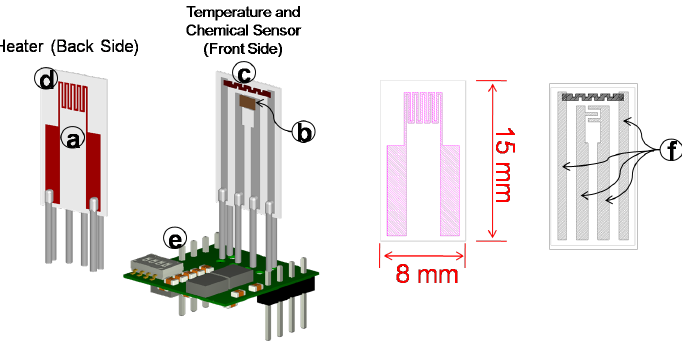
Figure 5. Sensor structure: ( a ) alumina substrate; ( b ) sensing film; ( c ) temperature sensor (Pt-Resistance Temperature Detector (RTD)); ( d ) heater; ( e ) conditioning and acquisition electronics; ( f ) Ag-Pt conductor